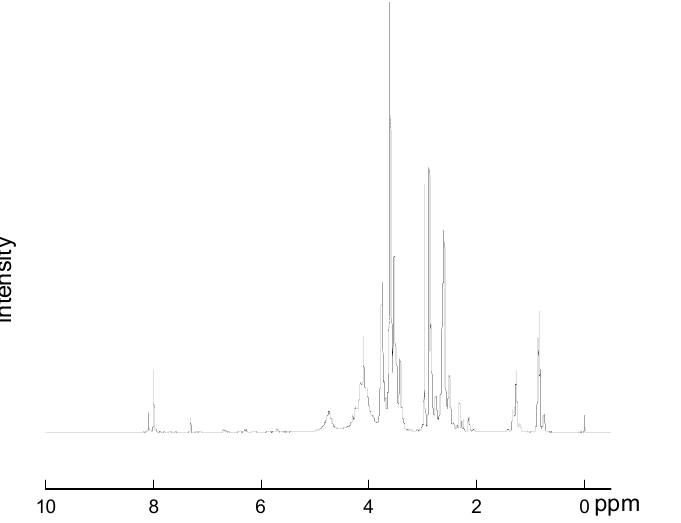
Figure 3. 1 HNMR spectra of water-borne polyurethane acrylate modified by hyperbranched silicon.